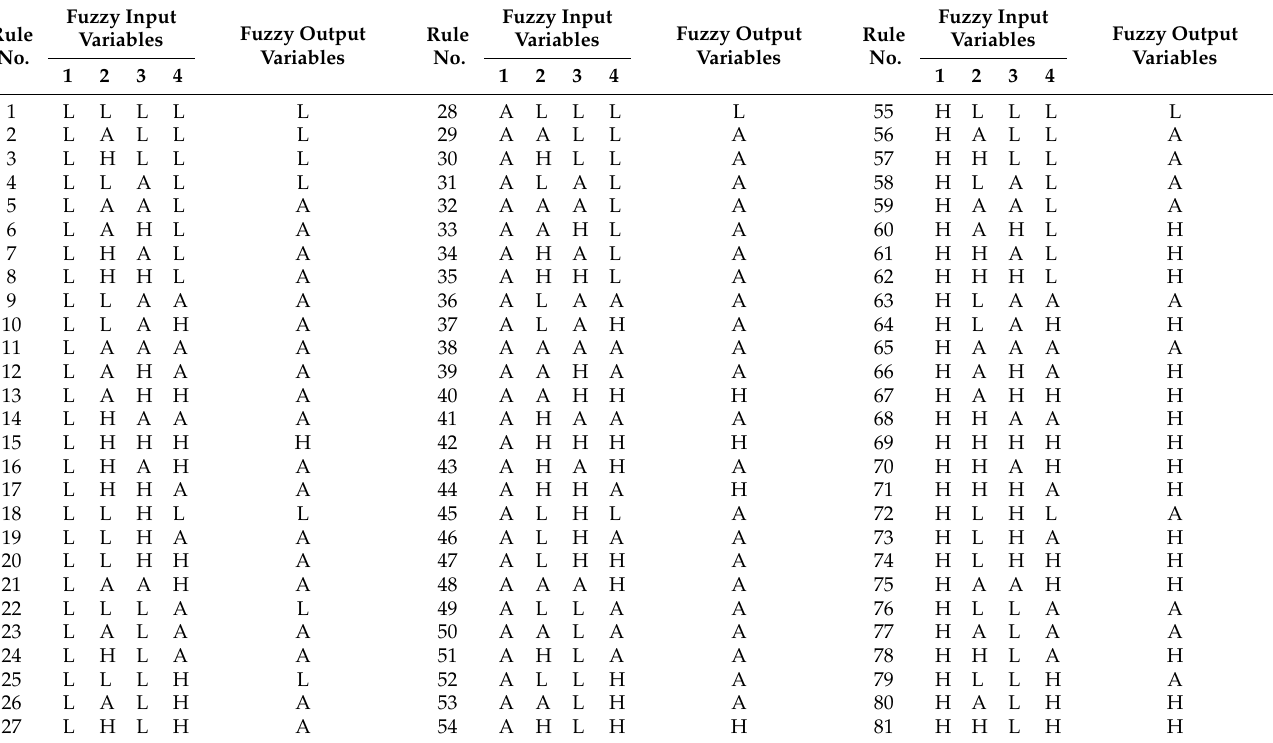
Table 5. Fuzzy IF-THEN γ